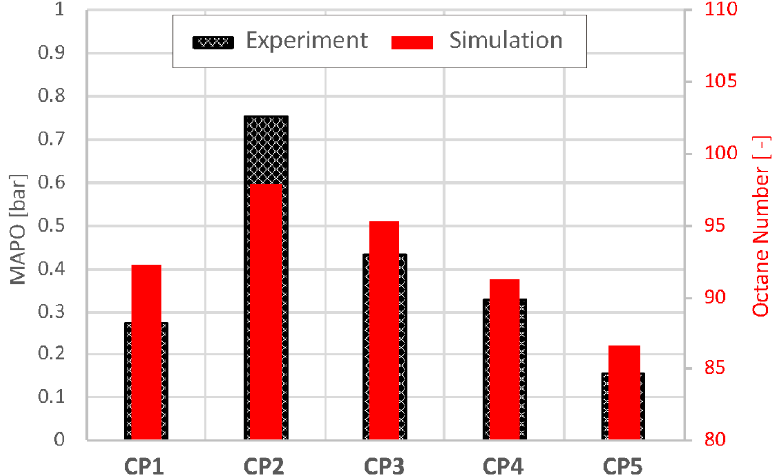
Figure 11. Comparisons of maximum amplitude of pressure oscillations (MAPO) and calculated fuel octane number (ON) from 0D/1D simulation.